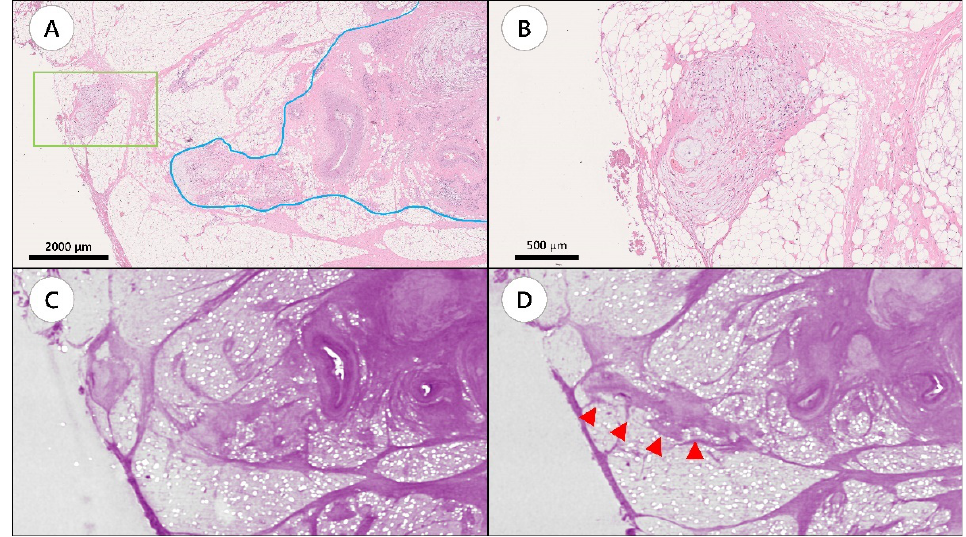
Figure 2. A representative case showing tumor connection between tumor deposit and primary tumor site by whole-block imaging. ( A ) Hematoxylin and eosin (H&E) slide showing tumor deposit (green box) and the primary tumor site (blue line). ( B ) Magnified image of the area in the green box. ( C ) Whole-block imaging of slide A. ( D ) Serial images of the block. Tumor connection was observed (arrow heads) LVI was detected using WSI in seven cases represented by 107 LVIs in 55 H&E slides. LVI was detected using WBI in seven cases represented by 96 LVIs in 53 FFPE blocks. WSI